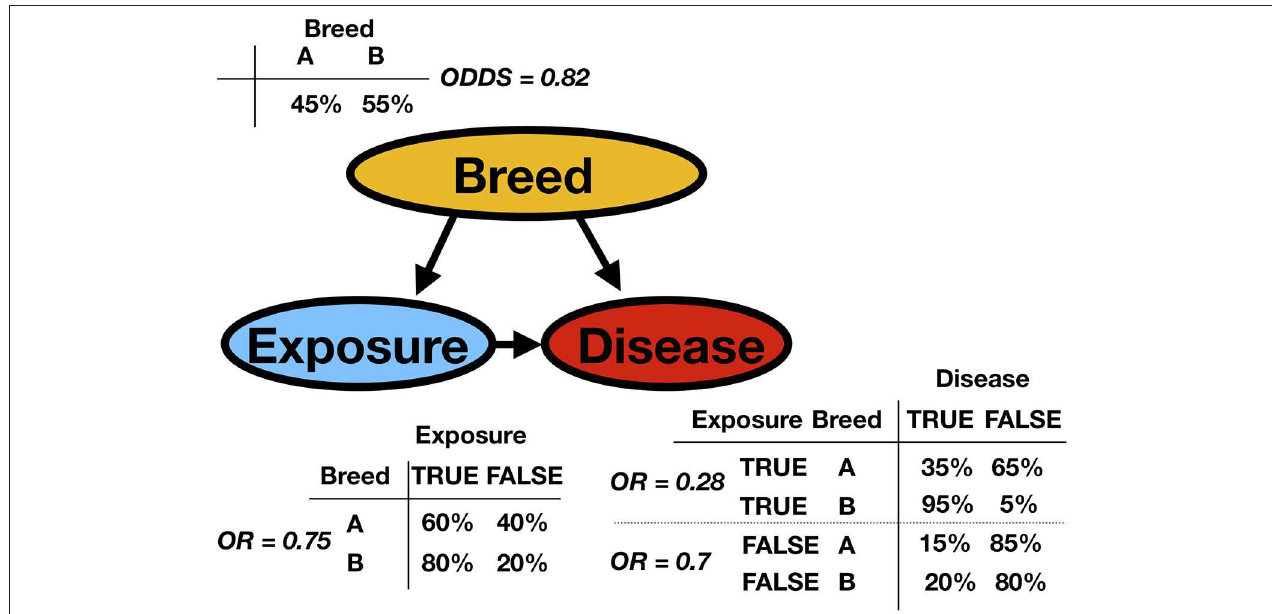
FIGURE 2 | A simple synthetic discrete Bayesian network is presented (represented as a DAG) with the conditional probability tables (CPT) and the corresponding odds or odds ratios (OR). A certain disease is studied in animal production. The observed variables are the animal’s breed and the exposure to sick animals. In the DAG, Breed is the parent of both Exposure and Disease . Exposure is the parent of Disease , as is indicated by the arrow. Inversely, one can say that Disease is the child of Exposure . From the column or row sums of the CPTs, it is possible to extract the marginal